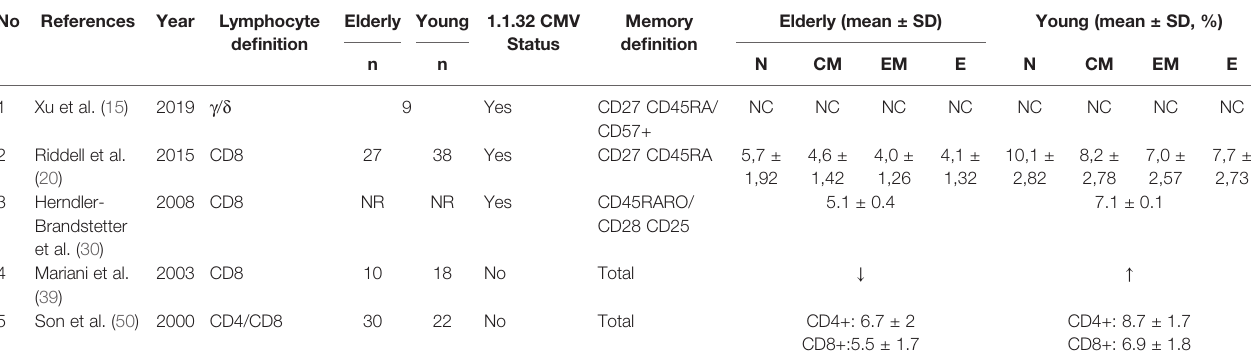
TABLE 4 | Characteristics of studies reporting telomere